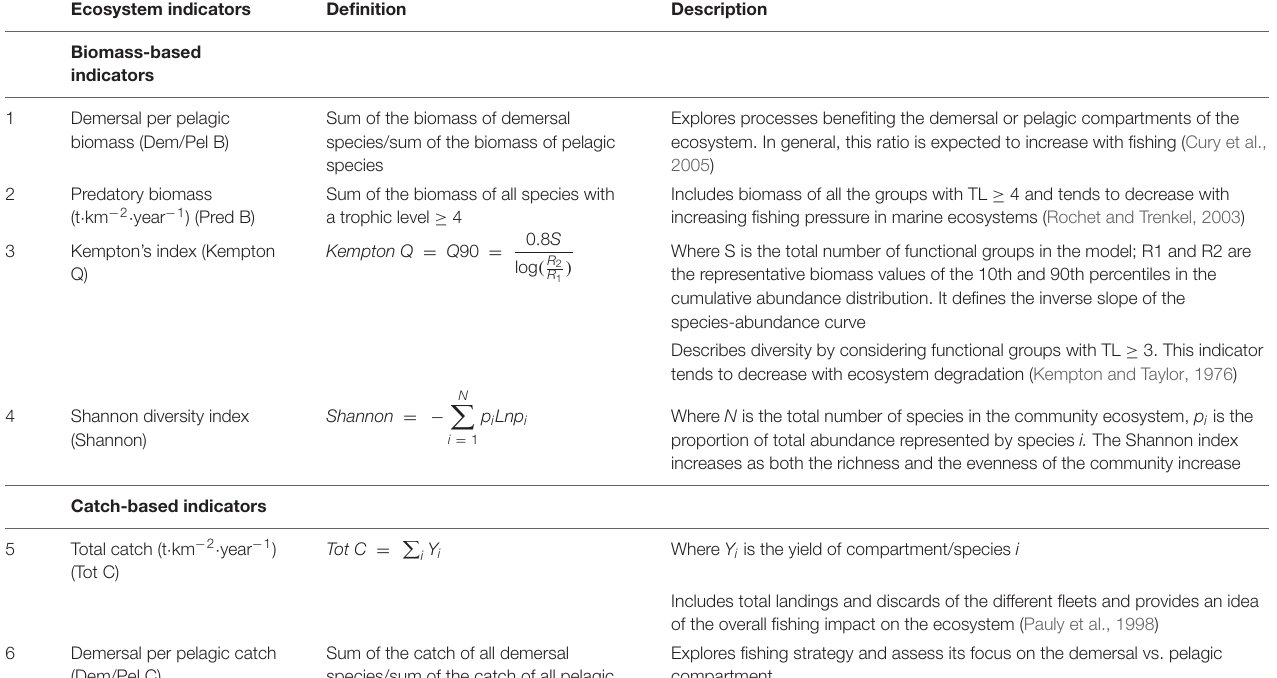
TABLE 2 | Ecosystem indicators calculated from Ecopath with Ecosim (EwE), that describe the Portuguese continental shelf ecosystem (PCSE) between 1986 and 2017. Ecosystem indicators